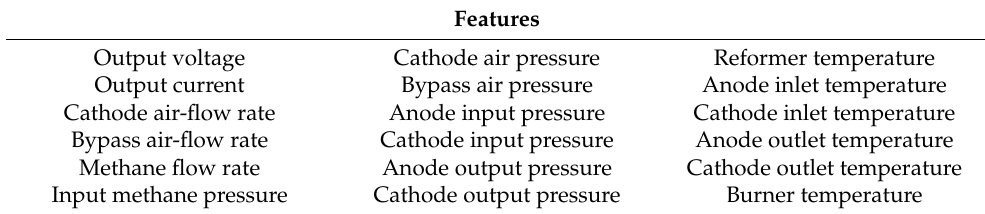
Table 1. Selected features of the SOFC